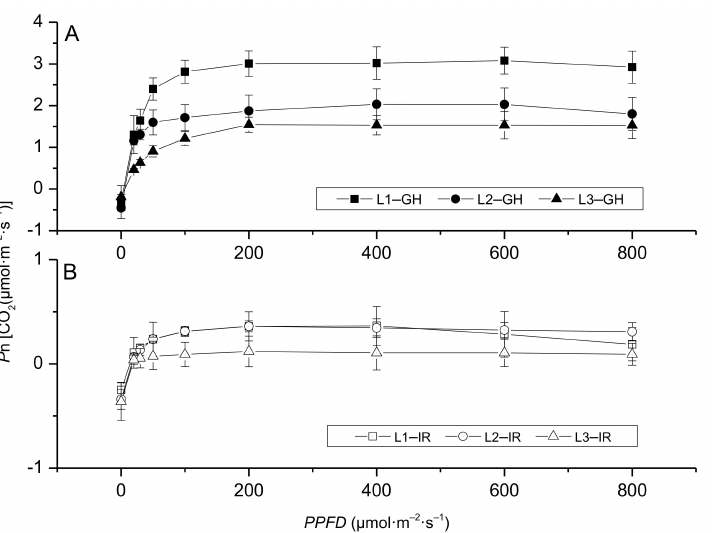
Figure 5. Response of net photosynthetic rate of Anthurium × ‘Red’ grown under a low light level (255 µ mol · m − 2 · s − 1 ) before ( A ) and after ( B ) placement to interior rooms. Where L: low light level, IR: interior room, and numeric values 1, 2, and 3 represent the bottom old leaf, center mature leaf, and the top young expanded leaf,